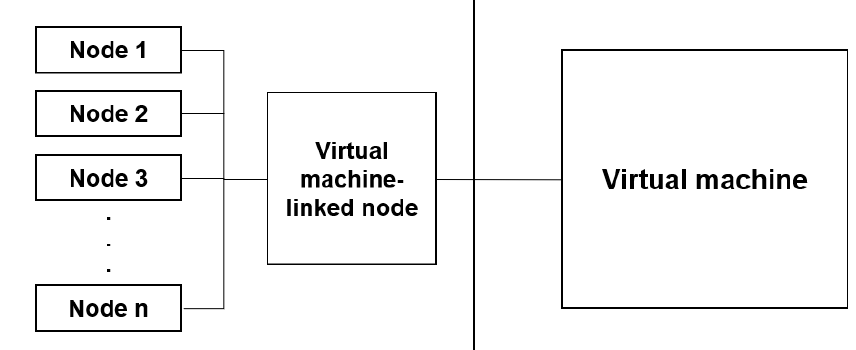
Figure 7. This figure shows the basic architecture of the virtual machine-based simulation node interoperation test environment configuration proposed in this paper. The user can configure the simulation nodes and the virtual machine as n:n according to the test